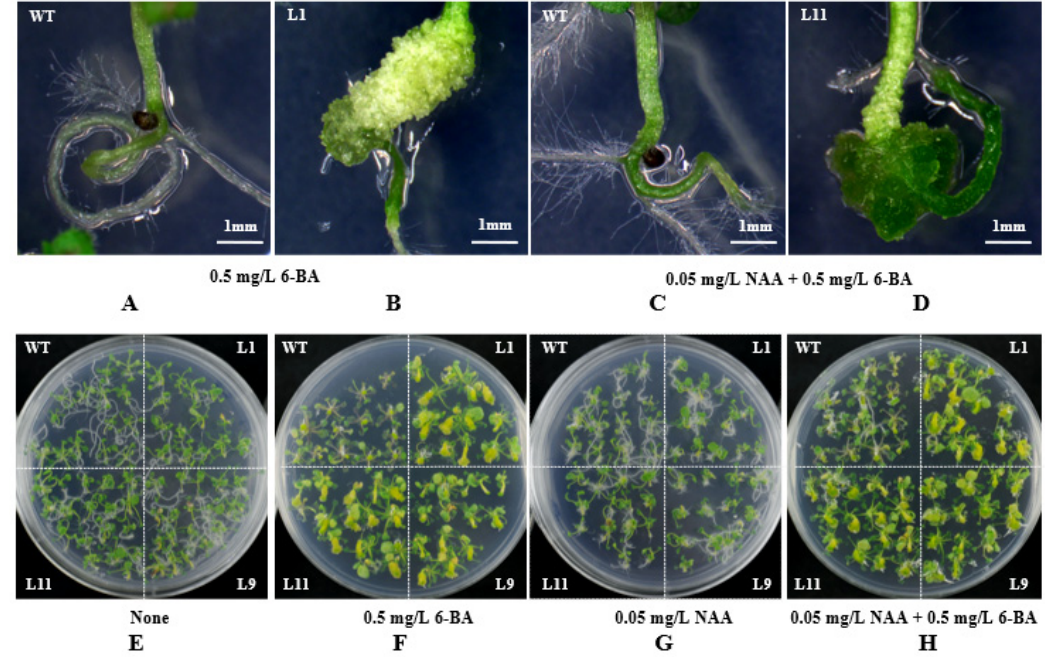
Figure 4. Response of transgenic seedlings to different hormones. ( A , B ) Enlarged view of wild-type and transgenic lines on MS medium containing 0.5 mg/L 6-BA. ( C , D ) Enlarged view of wild-type and transgenic lines on MS medium containing 0.05 mg/L NAA and 0.5 mg/L 6-BA. ( E ) MS medium without hormones. ( F ) MS medium containing 0.5 mg/L 6-BA. ( G ) MS medium containing 0.05 mg/L NAA. ( H ) MS medium containing 0.05 mg/L NAA and 0.5 mg/L 6-BA. WT, wild-type Arabidopsis seedlings; L1/9/11, three individual transgenic seedlings.